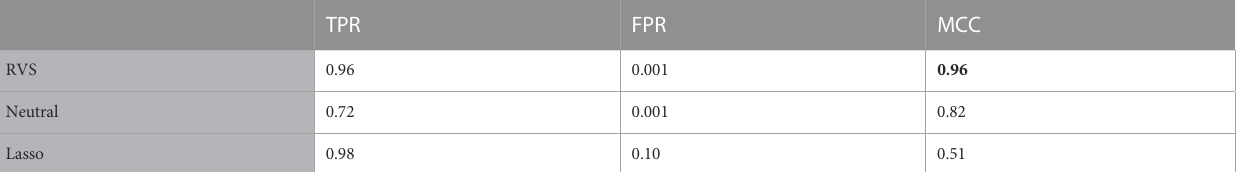
TABLE 4 Feature selection: The true positive rate (TPR), false positive rate (FPR), and Matthew ’ s Correlation Coef fi cient (MCC) for feature selection, for the simulated data with unequal group sizes. All metrics are averaged over 100 simulated data sets. The highest MCC value is indicated in bold.